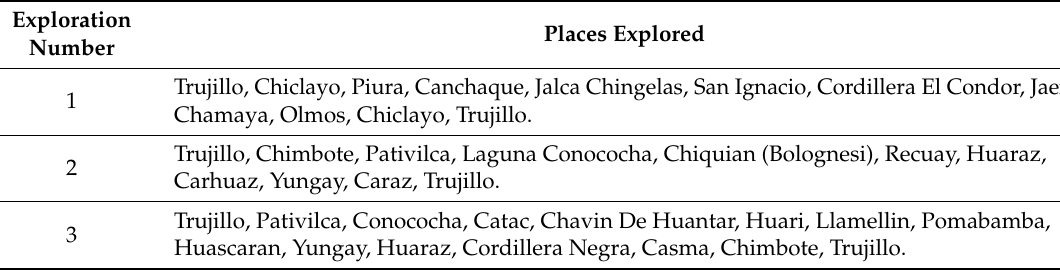
Figure 1. Botanical explorations conducted by the authors. Table 1. Botanical exploration routes.